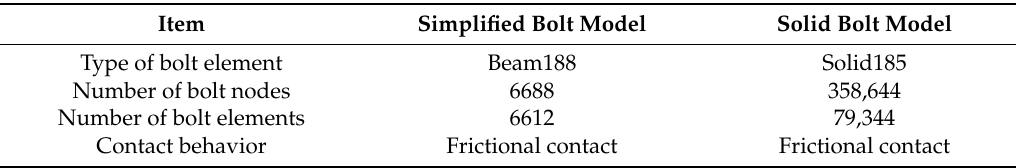
Table 3. Summary of finite element